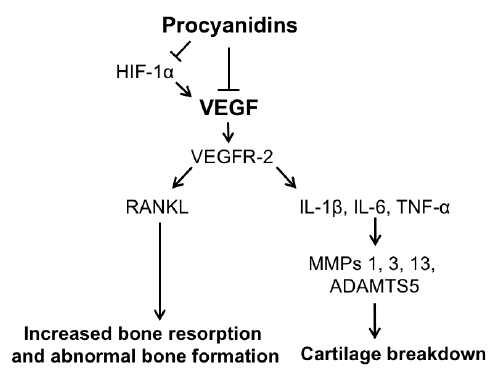
Figure 7. Hypothesized mechanism of procyanidin-mediated mitigation of OA pathogenesis. Procyanidins suppress expression of VEGF-mediated signaling by suppressing expression of VEGF and phosphorylation of VEGFR-2, and/or indirectly by reducing expression of HIF-1 α . Suppression of VEGF-mediated signaling downregulates expression of VEGF and its signaling pathway associated mediators, including pro-inflammatory cytokines IL-1 β , IL-6, and TNF- α , and proteolytic enzymes MMP-1, -3, -13, and ADAMTS5, which cleave components of the cartilage extracellular matrix. Procyanidins also suppress VEGF-induced RANKL, preventing increased bone resorption and abnormal bone formation.